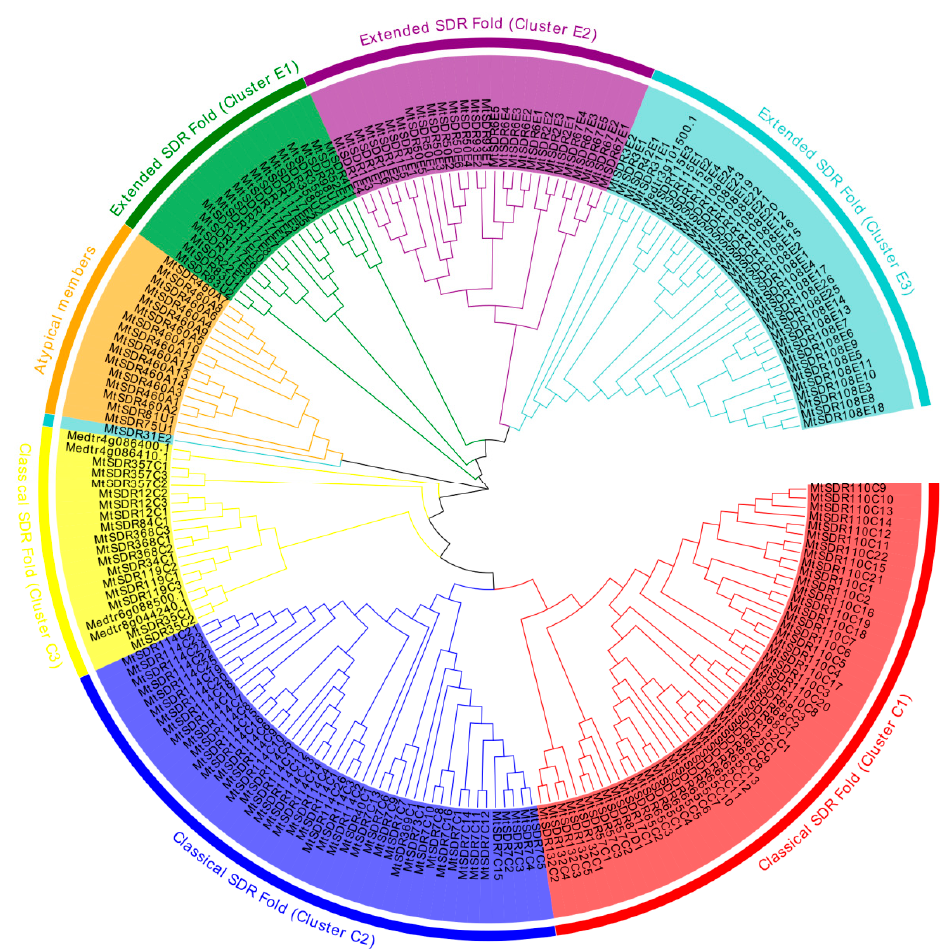
Figure 1. Phylogenetic tree of the domain relationship of MtSDRs. The different colors perform the different groups (or subgroups) of MtSDR.